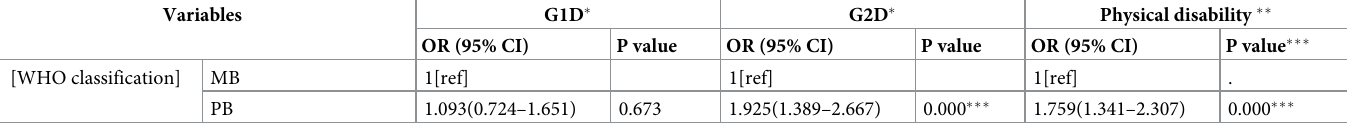
with leprosy reactions had an increased risk of G1D compared with patients without leprosy reactions, but there was no impact on G2D (P = 0.563) (Table 2). Similar to findings with G1D, no association of detection mode or contact history and risk of G2D was found (Table 2).